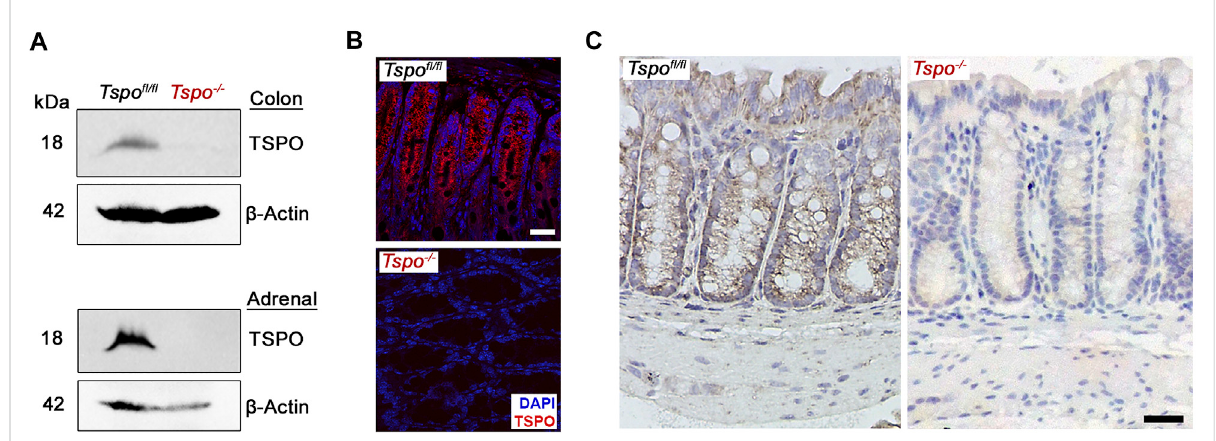
TSPO expression in Tspo fl / fl and Tspo − / − colons. (A) Western blot showing speci fi c recognition of TSPO in Tspo fl / fl but not in Tspo − / − colons; adrenals that show high expression of TSPO are presented for comparison.In thesame lanes, β -actin detection was used to indicate protein